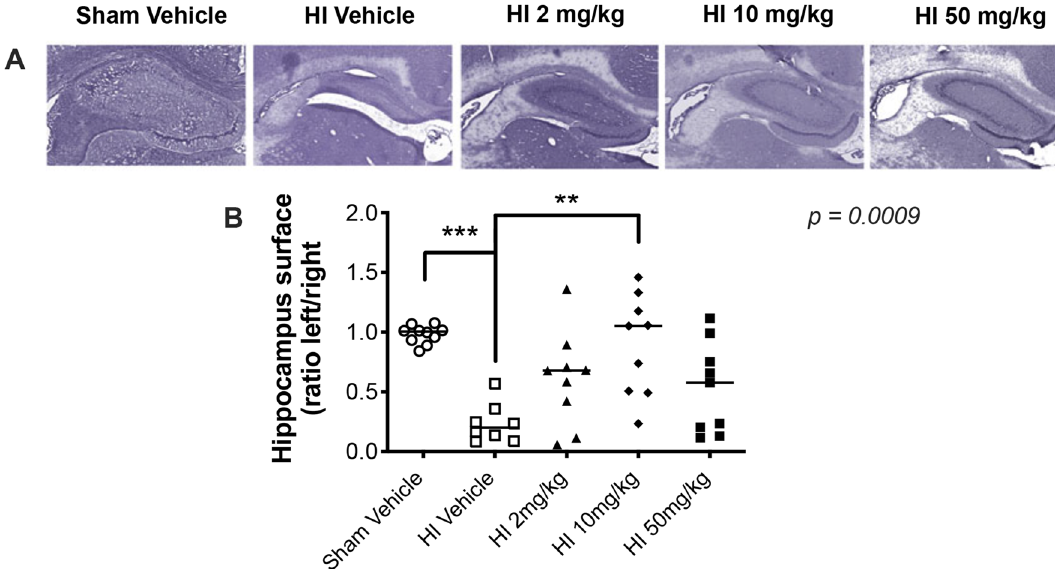
Figure 1. Hematoxylin and eosin-stained coronal brain sections in sham and HI rats treated with vehicle or sildenafil. ( A ) Representative hematoxylin and eosin-stained coronal brain sections showing the ipsilateral hippocampus. ( B ) Ipsilateral/contralateral hippocampus surface ratio (median with individual data points representation). Significance: p value from Kruskal–Wallis test, with Dunn’s post-hoc comparison tests: ** p < 0.01, *** p < 0.001. Number of animals: n = 10 sham rats treated with vehicle (sham vehicle), 8 HI rats treated with vehicle (HI vehicle), 9 HI rats treated with a low-dose (2 mg/kg) of sildenafil (HI 2 mg/kg), 9 HI rats treated with a medium-dose (10 mg/kg) of sildenafil (HI 10 mg/kg) and 9 HI rats treated with a high-dose (10 mg/kg) of sildenafil (HI 50